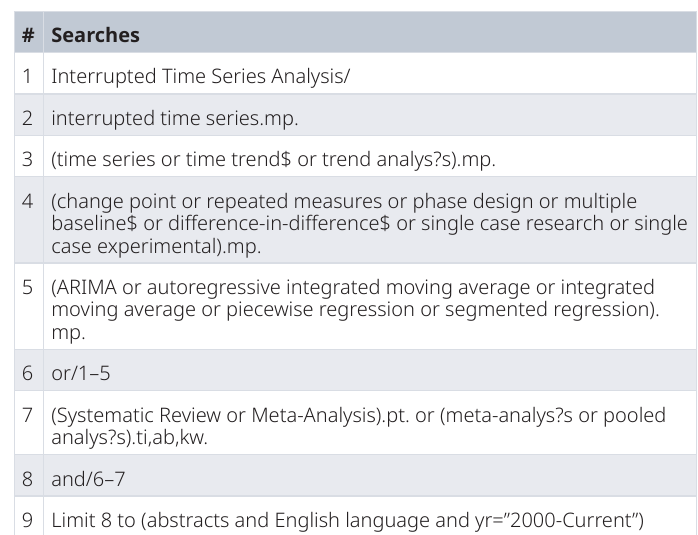
Table 1. MEDLINE (Ovid) search